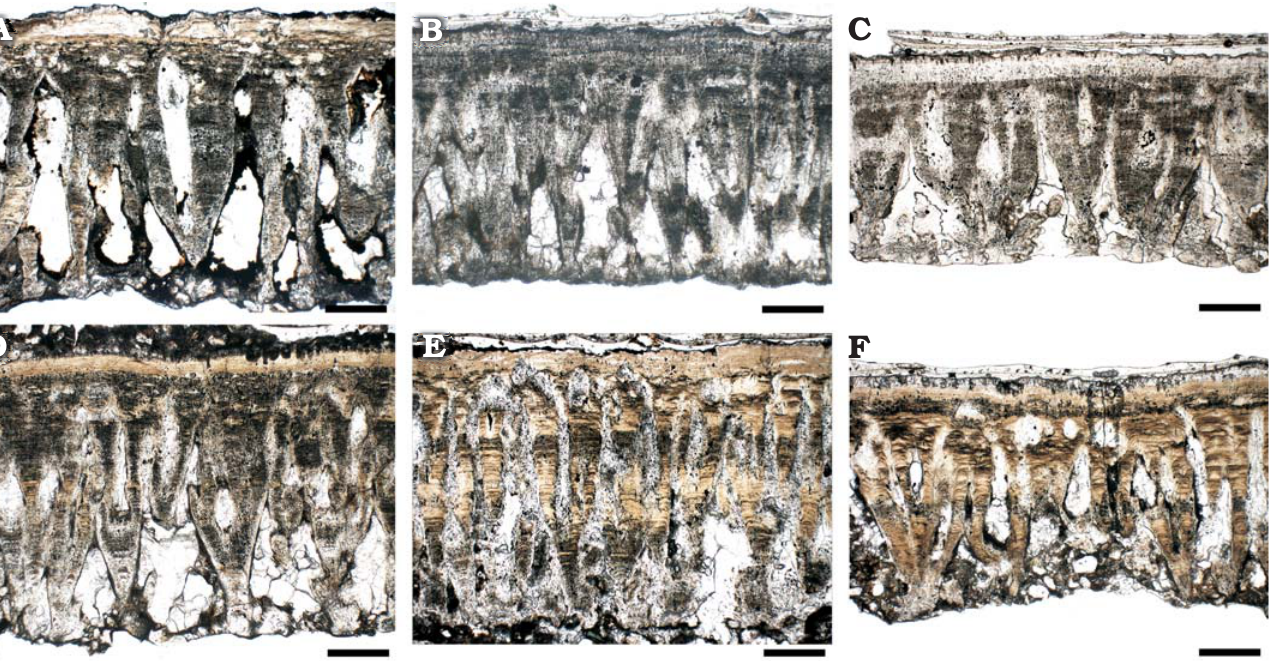
Fig. 4. Radial thin sections showing variety of dendroolithid eggshell microstructure of Placoolithus tumiaolingensis (Zhou, Ren, Xu, and Guan, 1998) comb. nov. from the Upper Cretaceous of the Tumiaoling outcrop, Yunxian, Hubei Province, China. A . TML 9, few branches. B . TML 10, fasciculate branches. C . TML 4, thinner eggshell. D . Eggshell from TML 4 with the Dendroolithus tumiaolingensis (Zhou, Ren, Xu, and Guan, 1998) microstructure from the Upper Cretaceous of the Tumiaoling outcrop, Yunxian, Hubei Province, China. E . Eggshell from TML 4 with Dendroolithus hongzhaiziensis (Zhou, Ren, Xu, and Guan, 1998) microstructure from the Upper Cretaceous of the Tumiaoling outcrop, Yunxian, Hubei Province, China. F . Eggshell from TML 8 with Paradendroolithus qinglongshanensis (Zhou, Ren, Xu, and Guan, 1998) microstructure from the Upper Cretaceous of the Tumiaoling outcrop, Yunxian, Hubei Province, China. Scale bars 400 μ